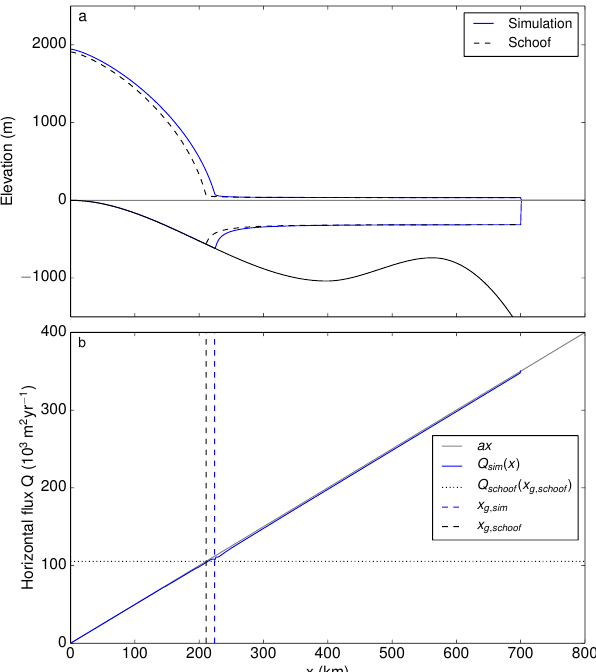
Figure A2. (a) Comparison between the semi-analytical ice-sheet profile from Schoof and our modeling result for the final steady- state ice sheet of simulation BC0 (only the RHS of the symmetric ice sheet is shown here). Panel (b) shows Schoof’s and the modeled grounding line position, x g , schoof = 211km and x g , sim = 224km, respectively, as well as the steady-state ice flux from simulation, Q sim (x) , along the model domain to compare with ax and the ana- lytically derived Schoof flux, Q g , at x g , schoof